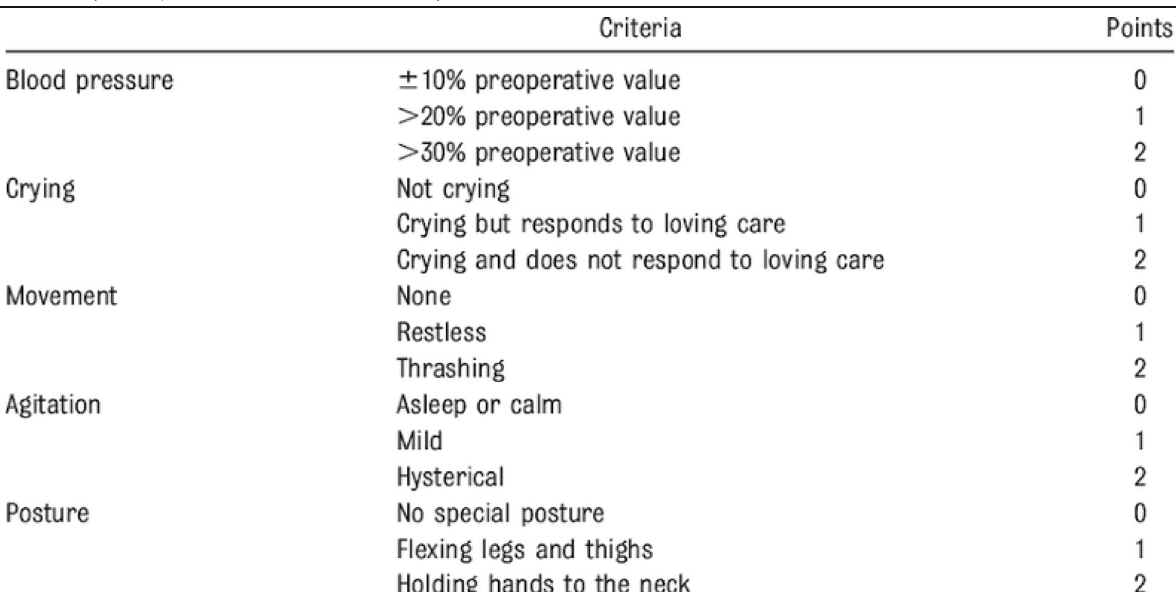
Table 1 Objective pain/discomfort scale (OPS)(Naja et al.,